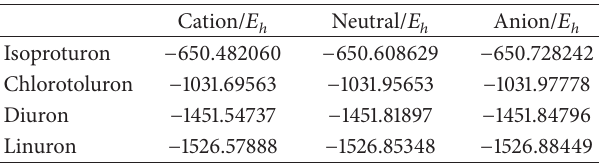
Table 1: Electronic energies calculated at the MP2/6-311++G(2d,2p) level of